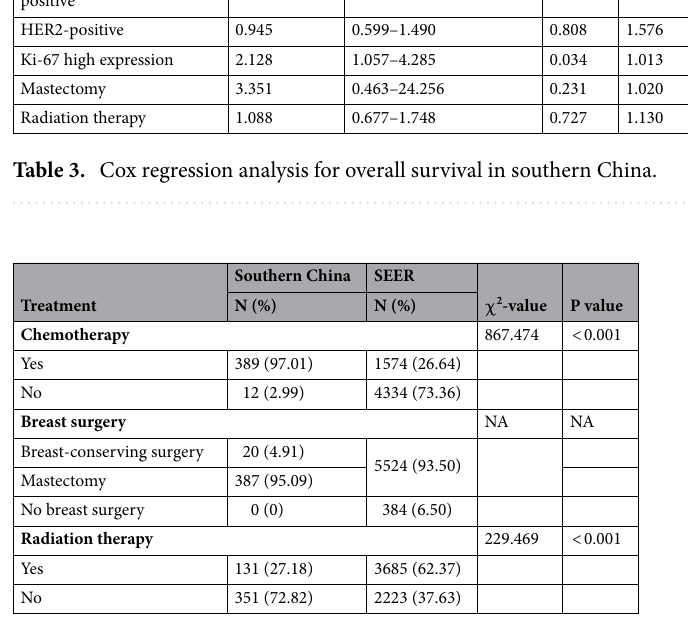
Table 4. Treatment of breast cancer patients in Southern China and SEER cohorts.